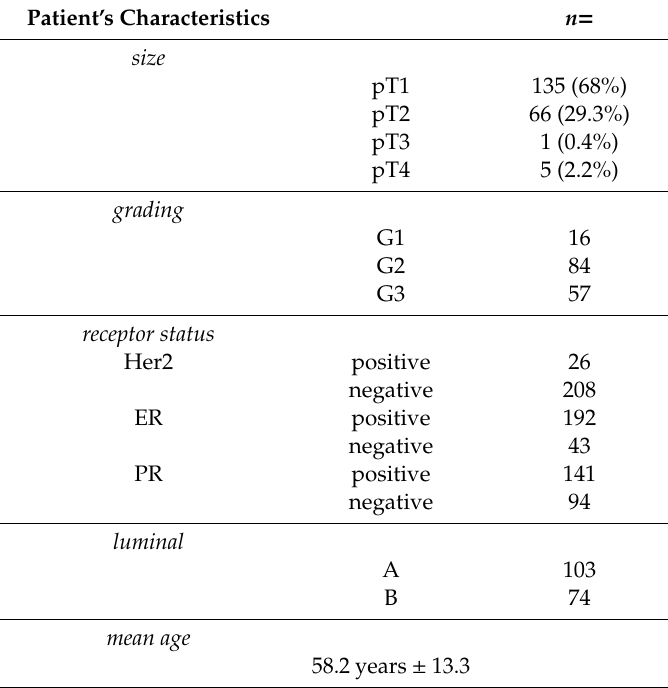
Table 1. Patient’s